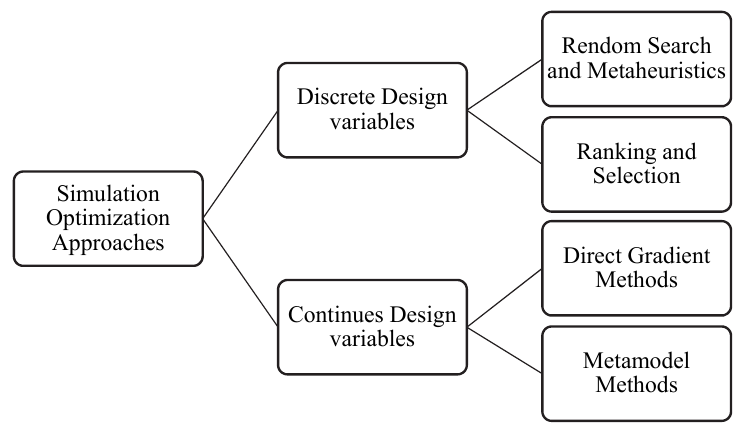
Fig. 7. Simulation optimization strategies based on nature of design